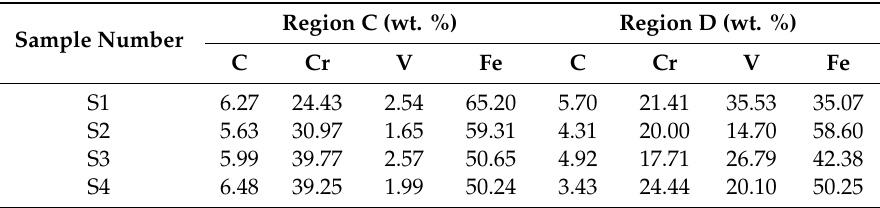
Table 5. Content of main alloy elements in regions C and D of wear-resistant Fe-based alloys on the outside of gradient